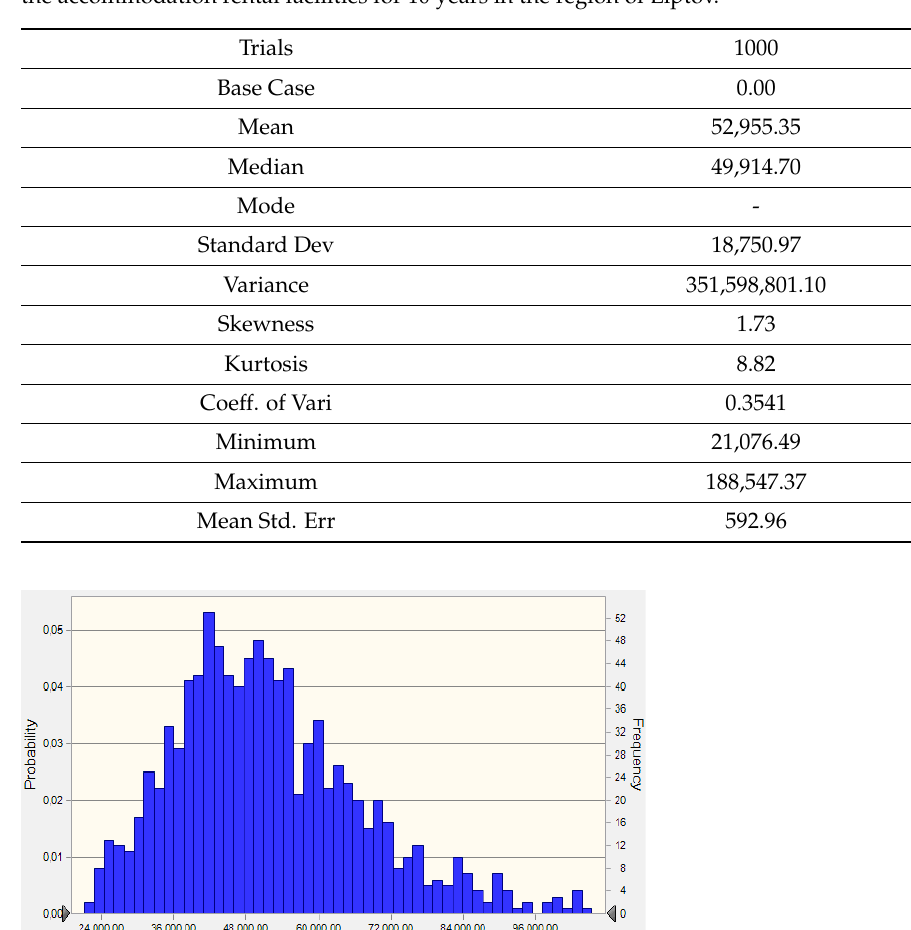
Figure 11. Probability distribution of the present value of incomes from the accommodation rental facilities for 10 years in the region of Liptov. facilities for 10 years in the region of Liptov.